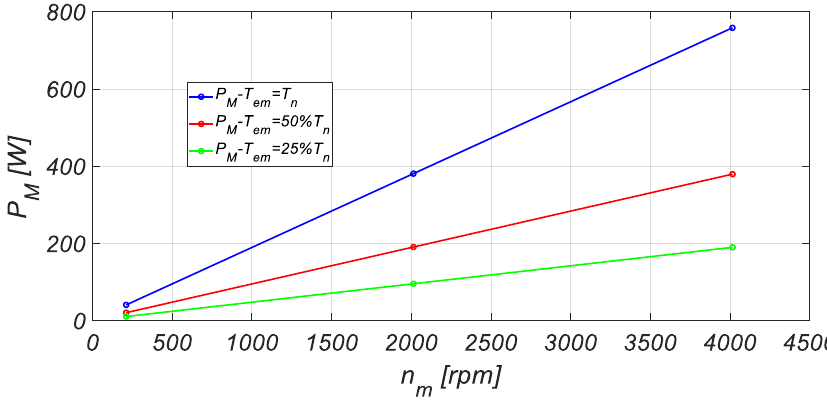
Figure 6. Mechanical power measured at I d = − 1 A.